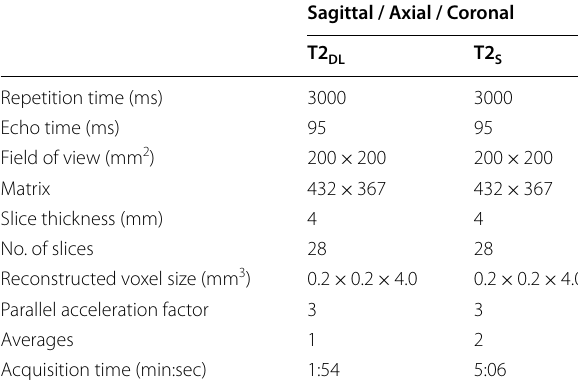
Table 2 Detail T2‑weighted MR imaging parameters for T2 T2 S